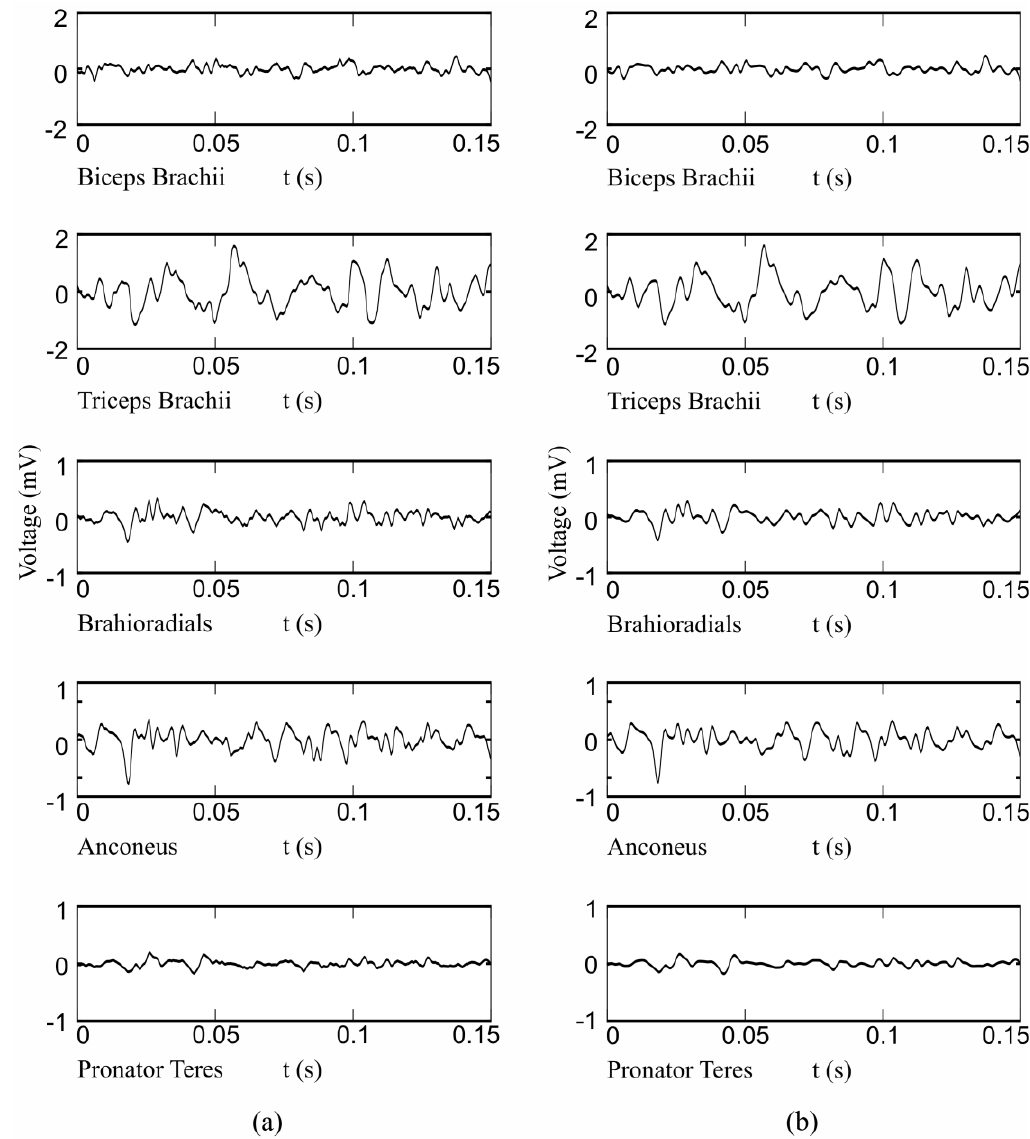
Figure B3. Example of recorded EMG signals from five muscles (biceps brachii, triceps brachi, brachioradialis, anconeus, bracioradialis, and pronator teres) during extension. Figure shows ( a ) raw signals and ( b ) signals filtered using 4th order Butterworth filter with the cut-off frequencies of 15 Hz and 350 Hz.